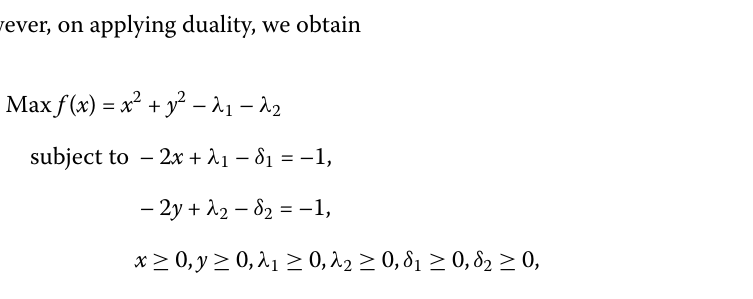
However, on applying duality, we obtain